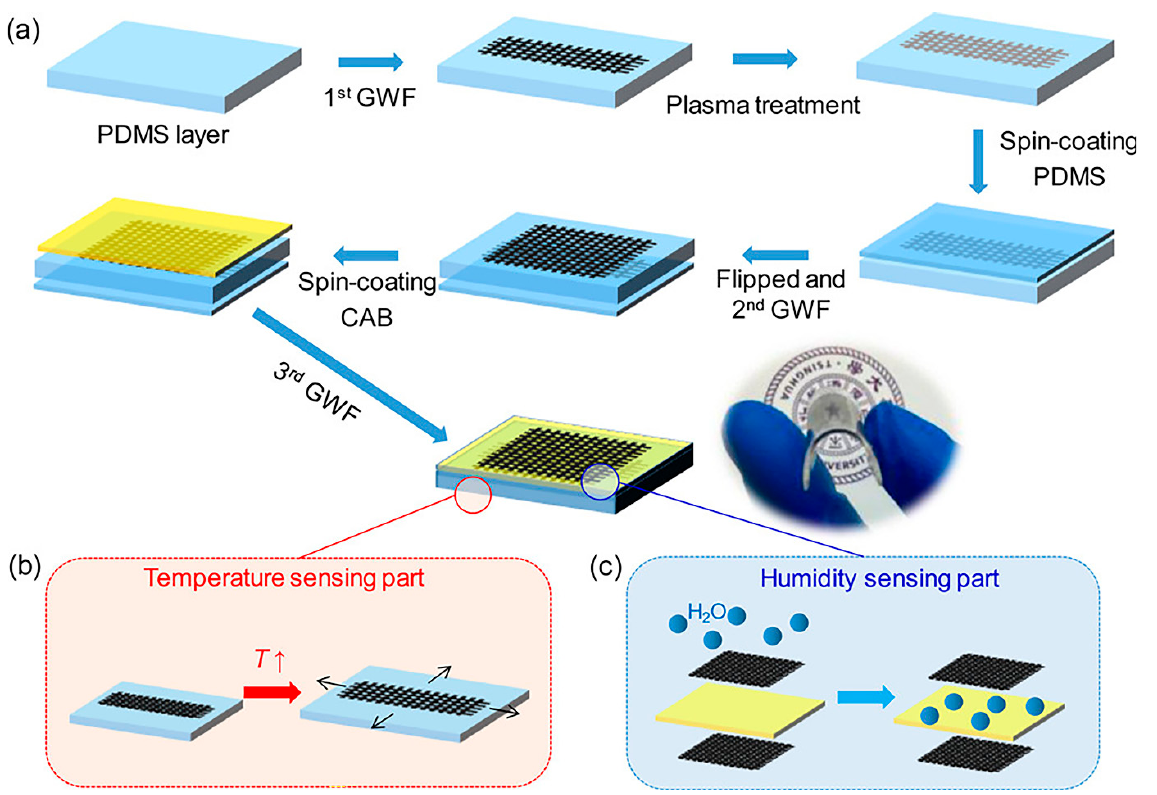
Figure 10. ( a ) Schematic diagram of the path to final FTHS. ( b ) Mechanism for temperature sensing. ( c ) The mechanism for humidity sensing [334], with permission from ACS Publications, 2017.